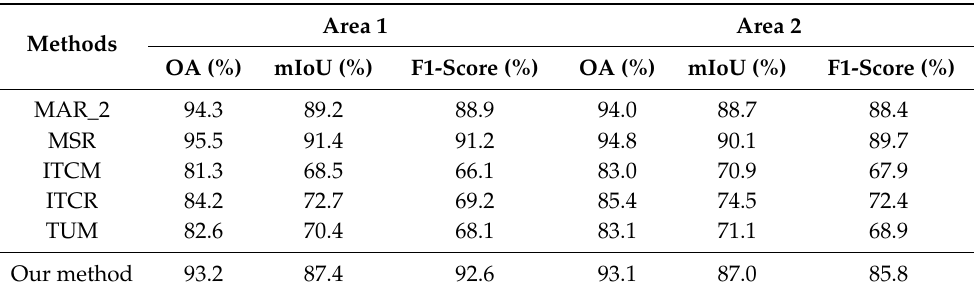
Figure 7. Misclassification cases in which roof points were recognized as ground points in the Toronto sites. ( a – c ) refer to different types of misclassification results from roof to ground separately. Table 2. Quantitative comparison of the proposed method and previous related methods tested on the Toronto sites. Two methods, MAR_2 and MSR, used only the point cloud for classification; MSR applied terrestrial digital models. ITCM, ITCR, and TUM used the point cloud and